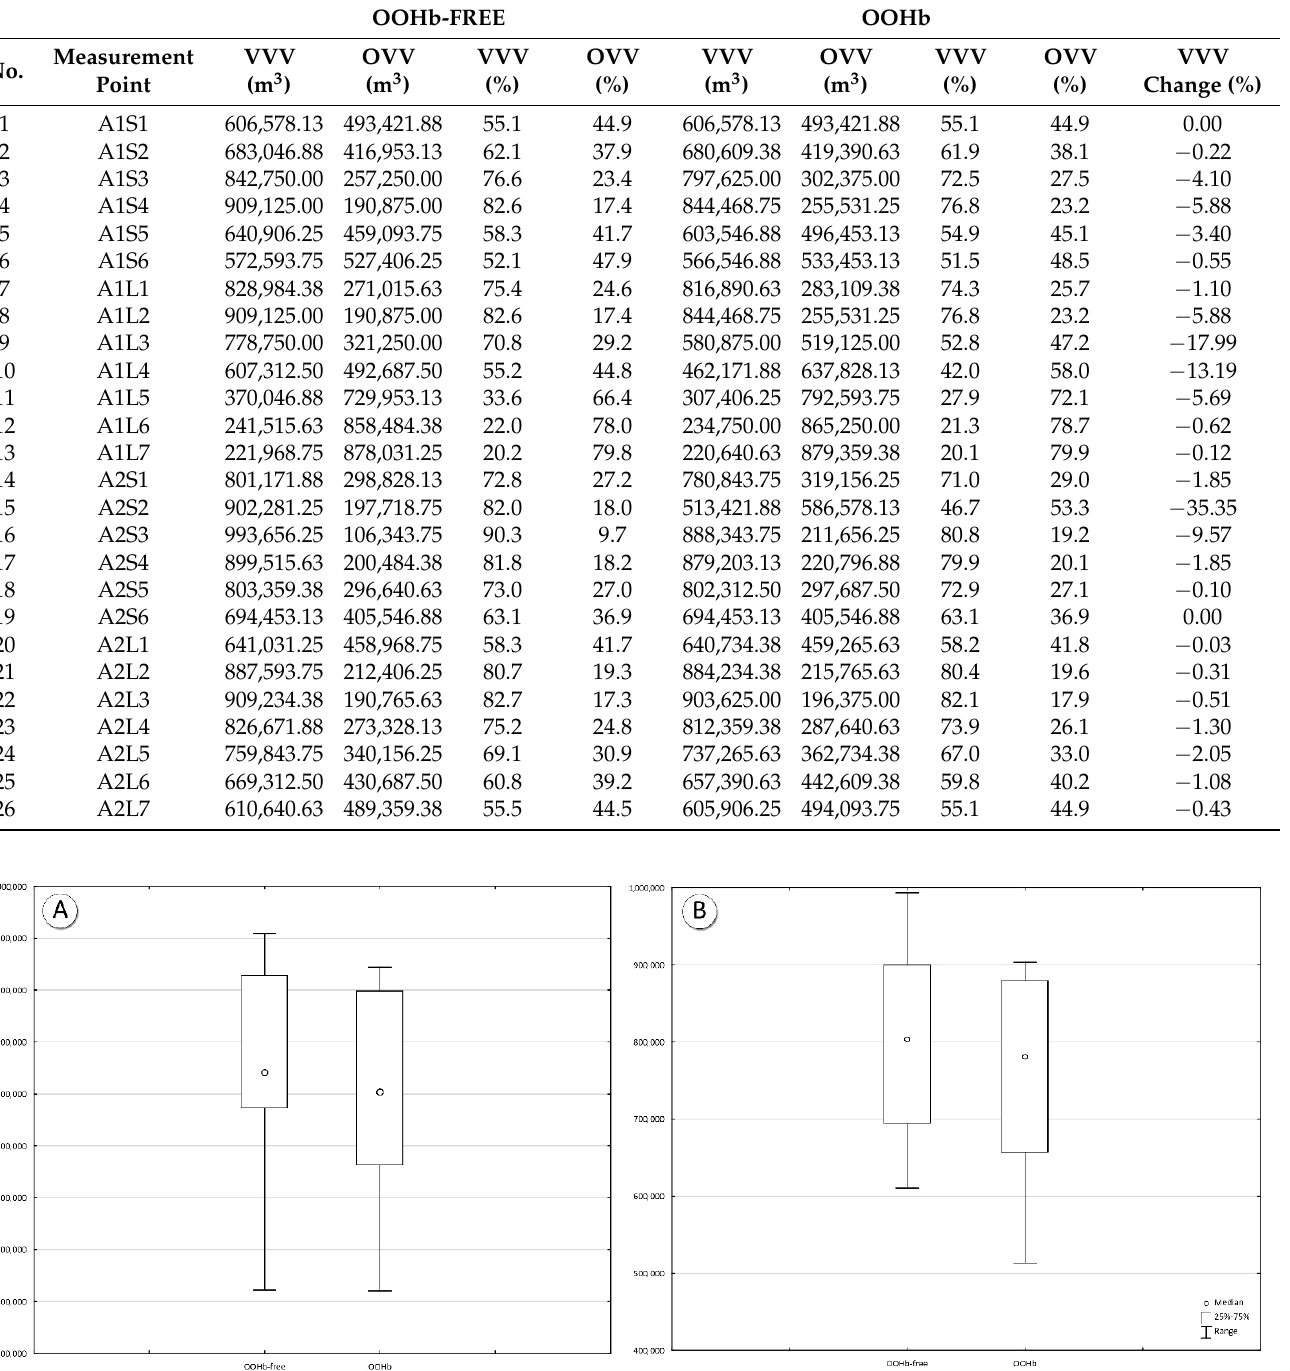
Figure 9. The visible volume decreases (the VVV parameter) as a result of OOHb occurrence in the landscape in botch cases studies: ( A ) the area “A”, ( B ) the area “B”.